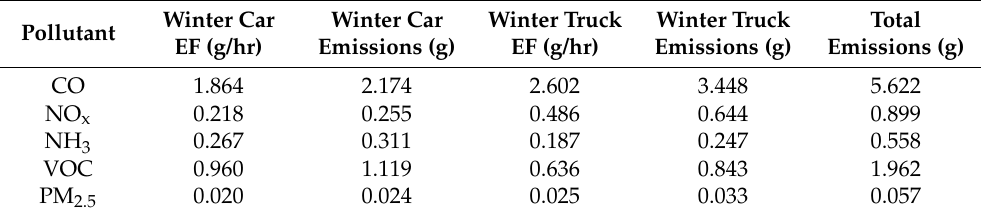
idling reductions.